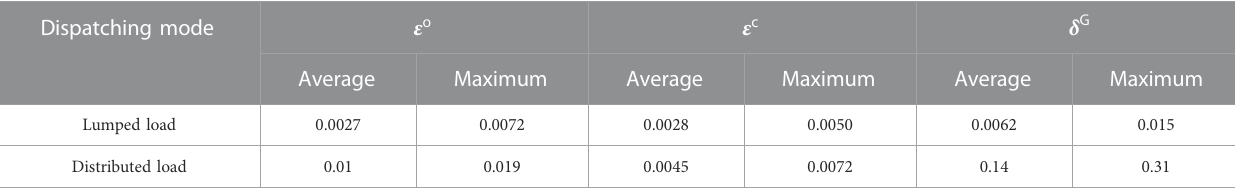
TABLE 2 Comparison of statistics of the knowledge validity index under lumped and distributed load